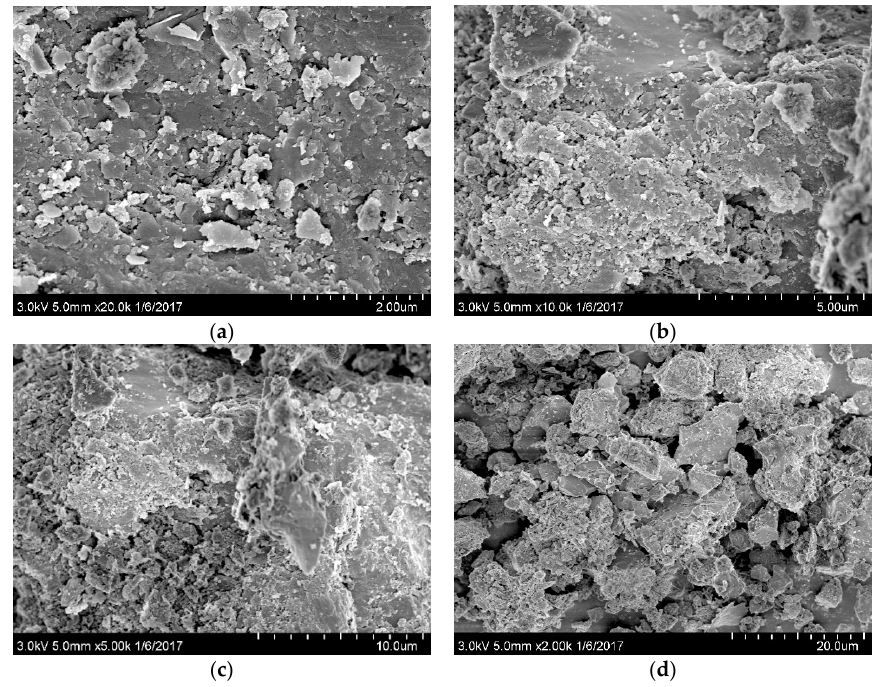
Figure 2. The scanning electron microscopy (SEM) image of lime sand bricks observed at different scales. ( a ) 2.00 μ m; ( b ) 5.00 μ m; ( c ) 10.0 μ m; ( d ) 20.0 μ m.